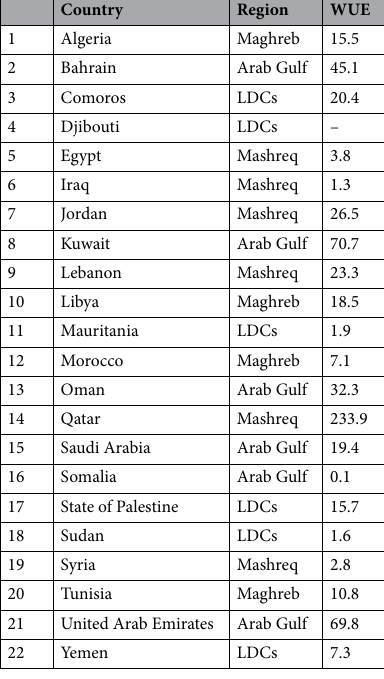
Table 3. WUE in the Arabsphere in USD/m 3